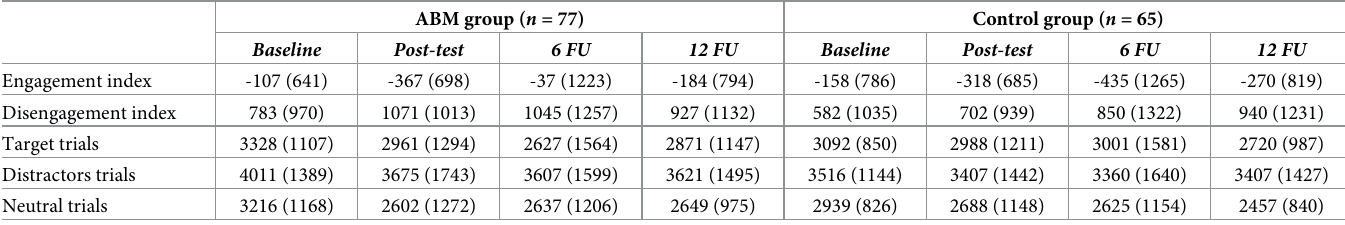
Table 4. Descriptives of the manipulation check per condition and time point.